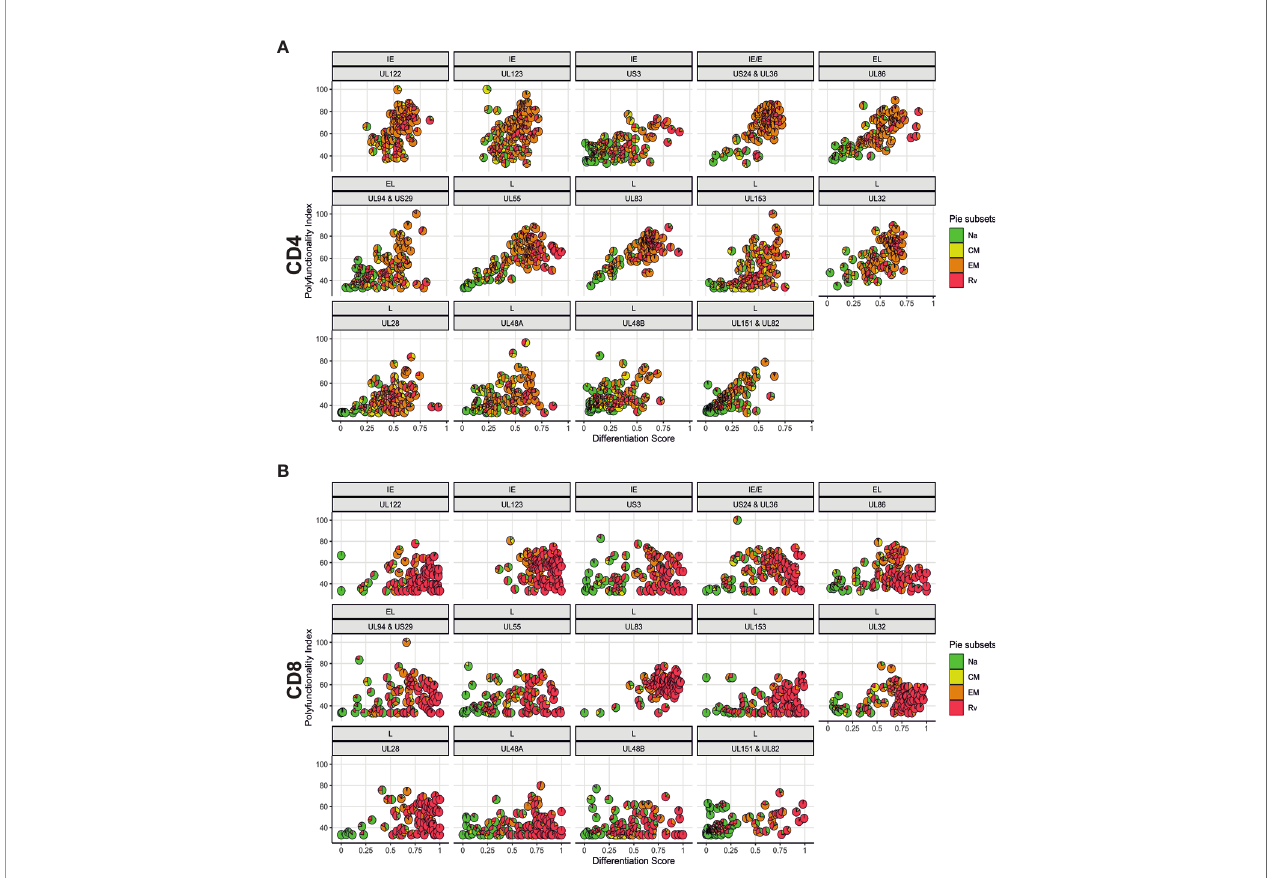
FIGURE 7 | Polyfunctionality plotted versus differentiation score reveals distinct, protein-associated patterns. (A) CD4 and (B) CD8 T-cell polyfunctionality (Polyfunctionality Index) in relation to differentiation score for each CMV protein pool strati fi ed according to the kinetics of the antigens. CMV protein designation and kinetic class are indicated at the top of each graph (in panels A, B ). Pie charts show memory subset distributions including naive-like/stem-cell memory (Na, green), (CM, yellow), effector memory (EM, orange), and revertant memory (Rv,